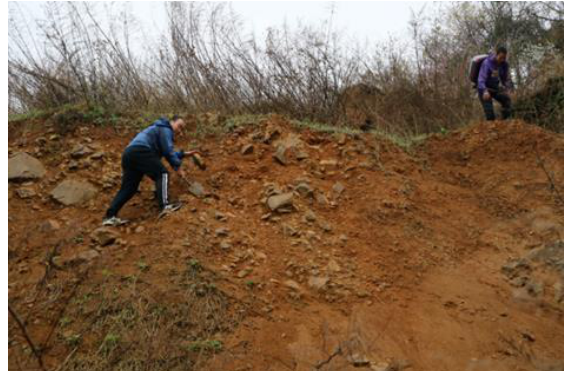
Figure 9. The slope of residual soil formed by the weathering of the basalt.